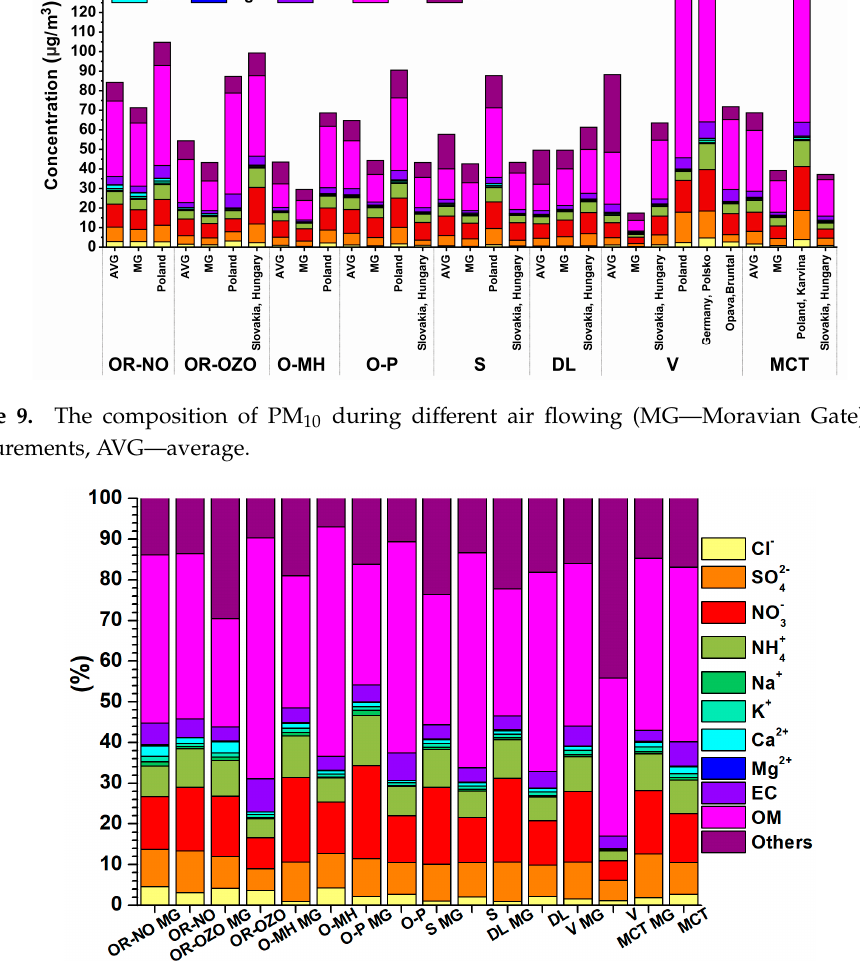
Figure 10. The chemical composition of PM 10 particles (%) for airflow from Moravian Gate (MG) and